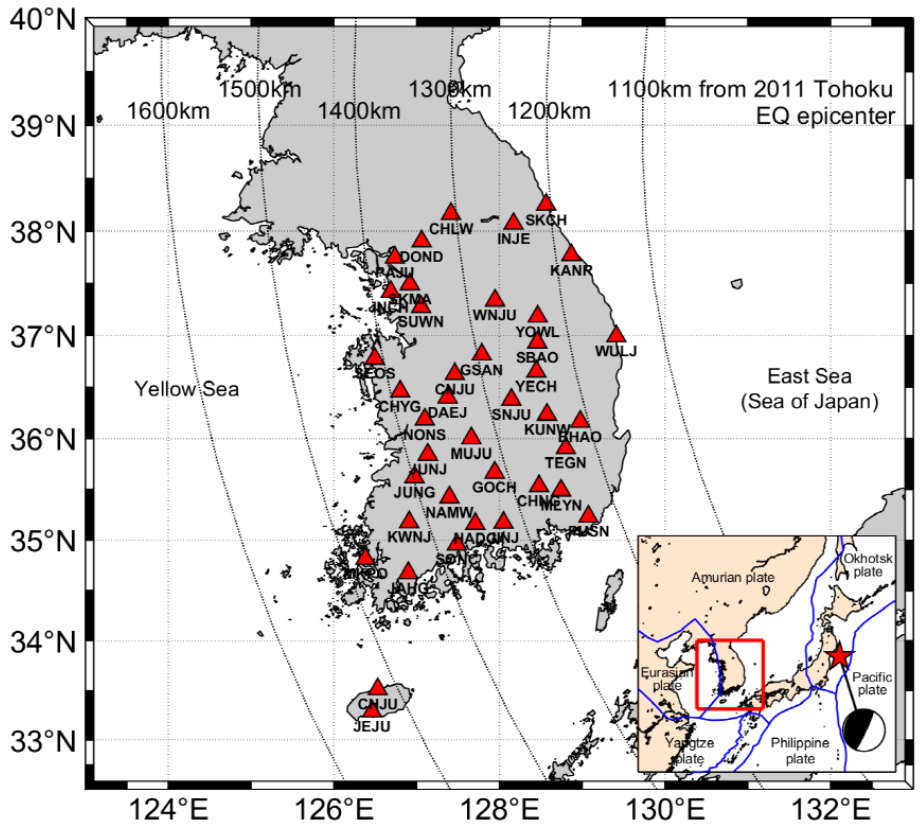
Figure 1. Locations of continuously operating GNSS stations (red triangles). The curved dotted lines represent the distance from the epicenter. Inset: The star marks the epicenter of the 2011 Tohoku-Oki earthquake. The blue lines represent the plate boundaries.